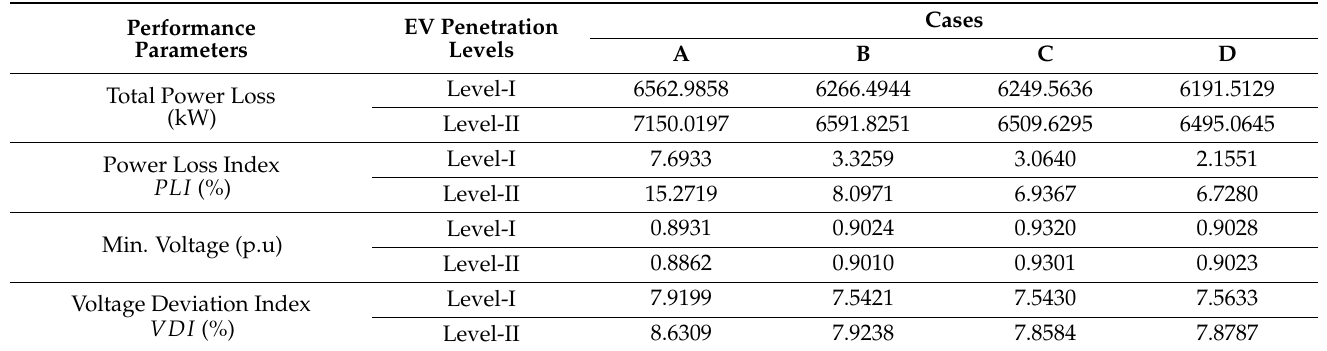
Figure 8. Case A: ( a ) Network power loss; ( b ) voltage deviation; ( c ) network power consumption .